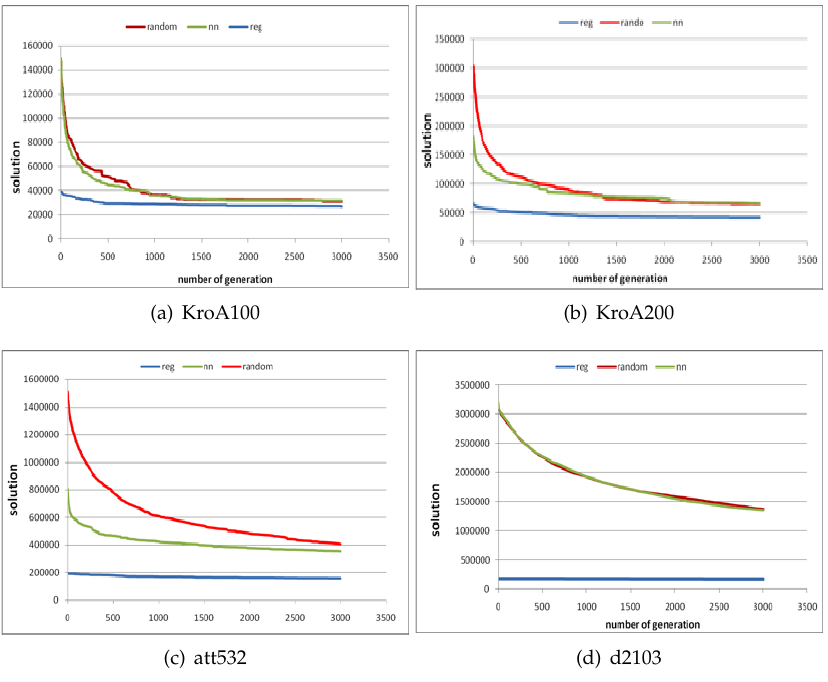
Figure 15. Performance for three techniques Random, NN and our Regression with respect to the number of generations for ( a ) KroA100, ( b ) KroA200, ( c ) att532, and ( d )